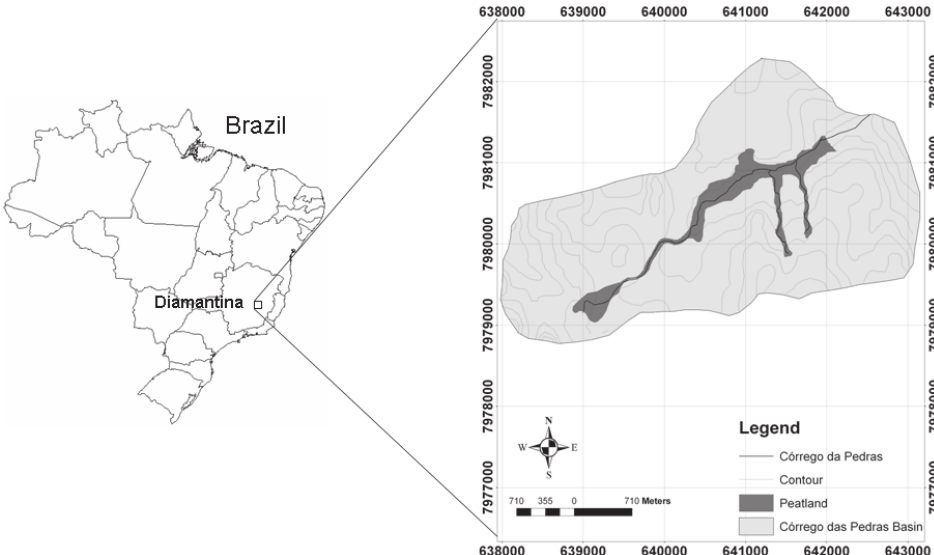
figure 1. location of the study